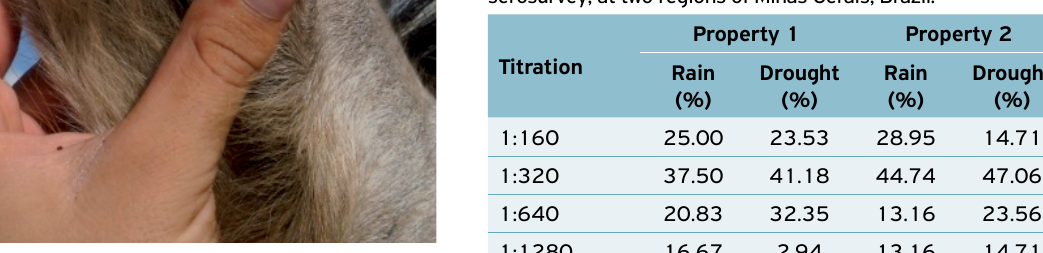
Figure 1. Equine pinna showing ticks’ infestation.